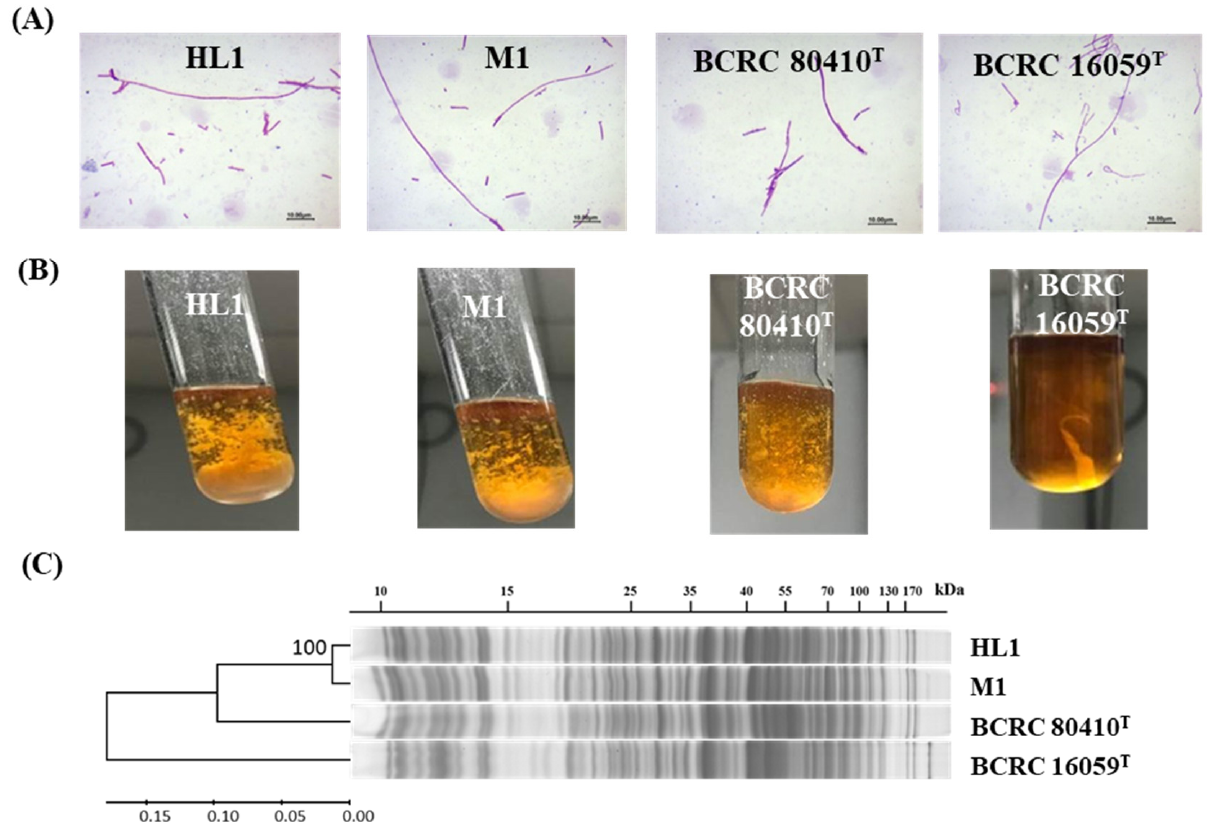
Figure 1. Phenotypic characteristics of L. kefiranofaciens strains HL1 and M1. ( A ) Morphology of cells grown in MRS broth; ( B ) Bacterial growth aspect in MRS broth; and ( C ) SDS-PAGE whole-cell protein profiles of four strains of L. kefiranofaciens . The banding patterns were clustered together using the UPGMA algorithm. The evolutionary distances are in the unit of the number of band differences per site, as calculated by p-distance. Table 1. Differential carbohydrate fermentation characteristics of L. kefiranofaciens strains HL1 and M1, and their closest related type strains by API 50 CHL system . +, Positive; −, negative; w, weakly positive.